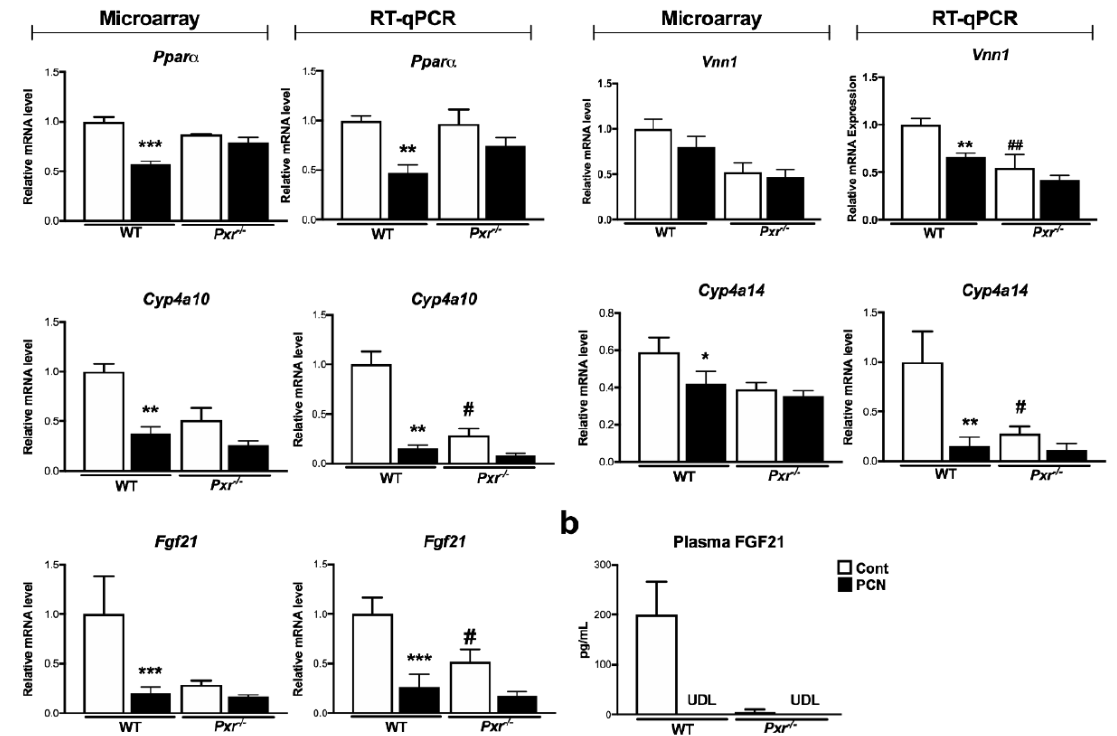
Figure 4. Impact of PXR activation on hepatic PPAR α activity. Gene expression in the liver ( a ) derived from the microarray and from complementary qPCR experiments. ( b ) Plasma levels of FGF21. Data are mean ± SEM of n = 5–6 per group. * p ≤ 0.05, ** p ≤ 0.01, *** p ≤ 0.005 for PCN e ff ect, # p ≤ 0.05, ## p ≤ 0.01 for genotype e ff ect using 2-way ANOVA and Tukey’s post-tests. UDL: Under the detection